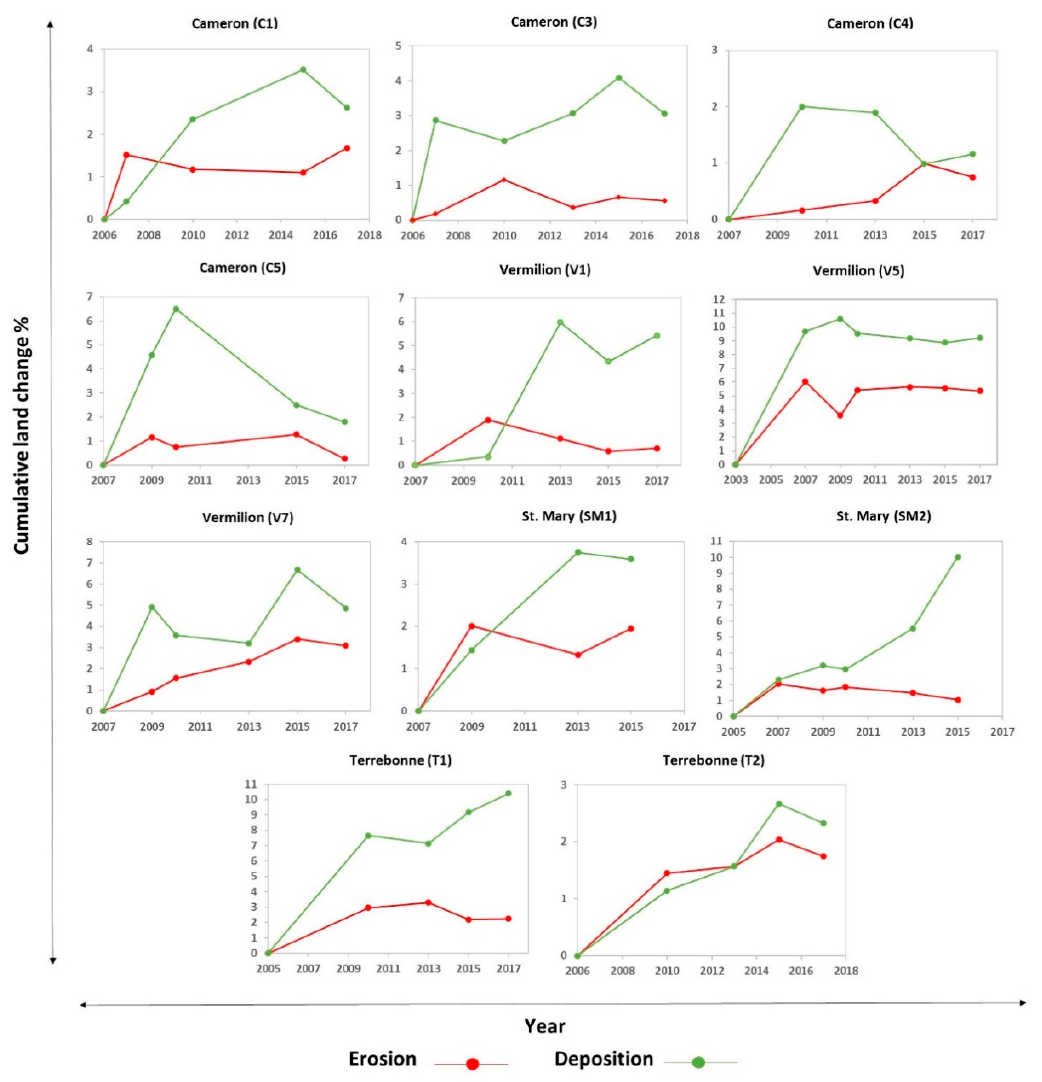
Figure 5. Land change trends of marsh terrace fields showing predominant deposition over time.